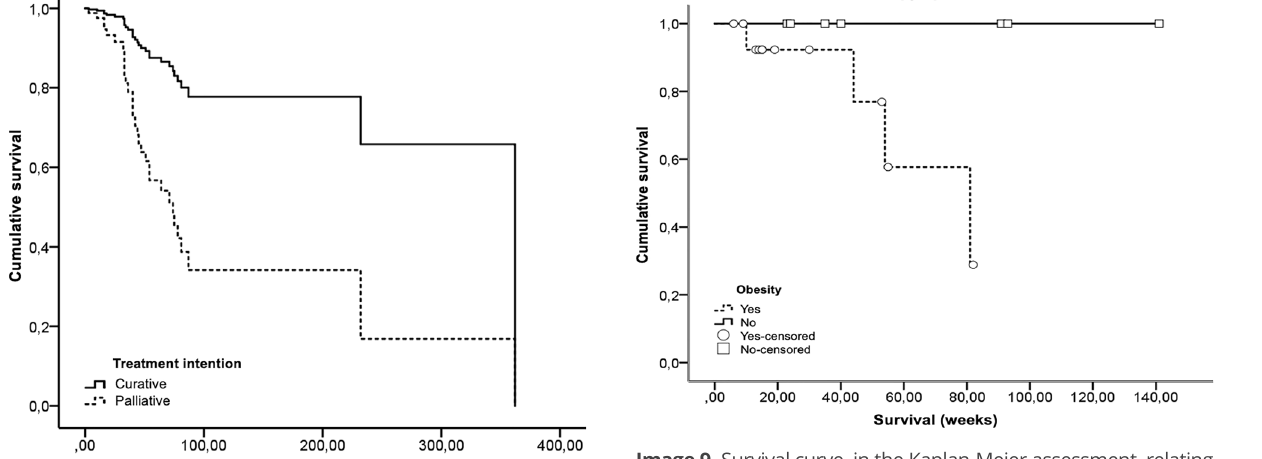
Image 9. Survival curve, in the Kaplan-Meier assessment, relating obesity to survival, among patients undergoing hormone therapy, with palliative treatment intent There was no difference in survival between non-obese and obese patients (Kaplan-Meier test - Log rank/Mantel-Cox: p=0.077)